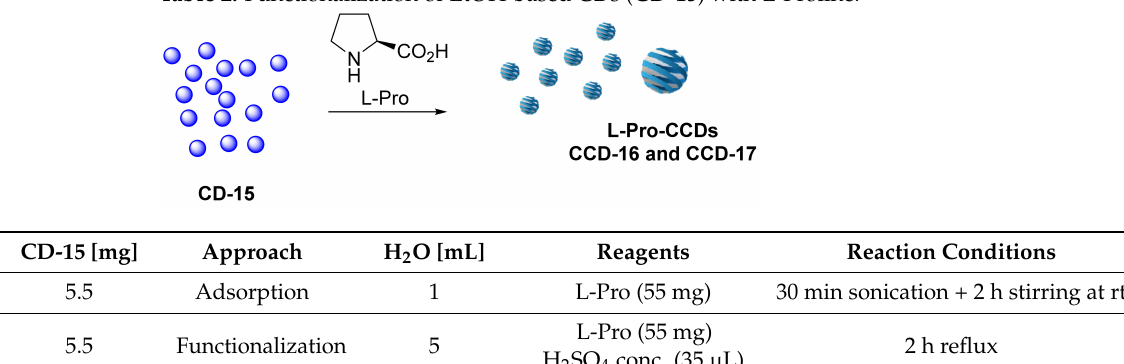
Table 2. Functionalization of EtOH-based CDs ( CD-15 ) with